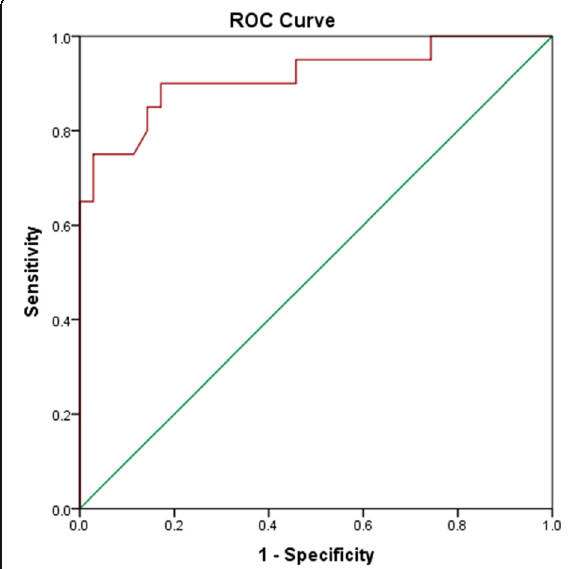
Fig. 6 Receiver operator characteristic curves: early detection of invasive urinary bladder carcinoma (AUC =